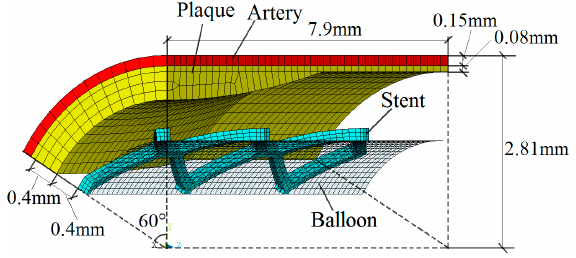
Figure 2. The finite element model of polymeric stent expansion in a stenotic artery. The 8-node solid element was assumed for the artery, plaque, and polymeric stent, while the shell element was assumed for the balloon. The balloon consists of 896 elements, with 56 elements along its length and 16 elements in circumference. The polymeric stent was discretized by 930 elements with 3 elements in the modeled thickness. The artery consists of 504 elements and the plaque consists of 960 elements.